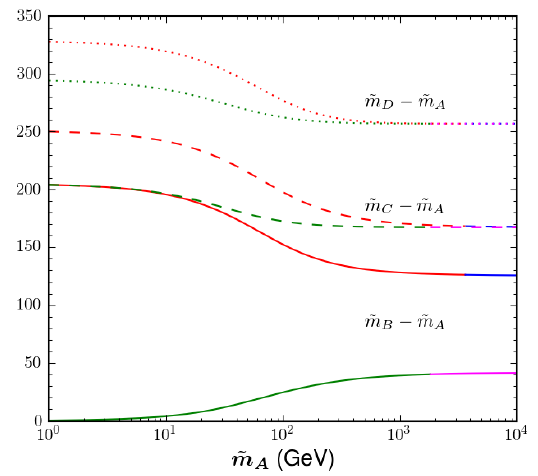
Figure 4 . Mass spectra along the (cid:13)at direction speci(cid:12)ed by the study point P ~ m A , we plot the mass di(cid:11)erences ~ m B (dotted lines), which would preserve the values for the three kinematic endpoints a , b and c